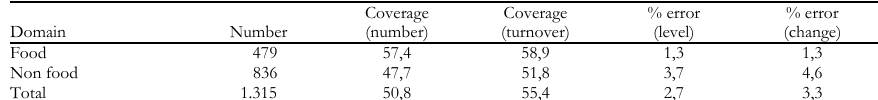
Main results using actual quick respondents – Average